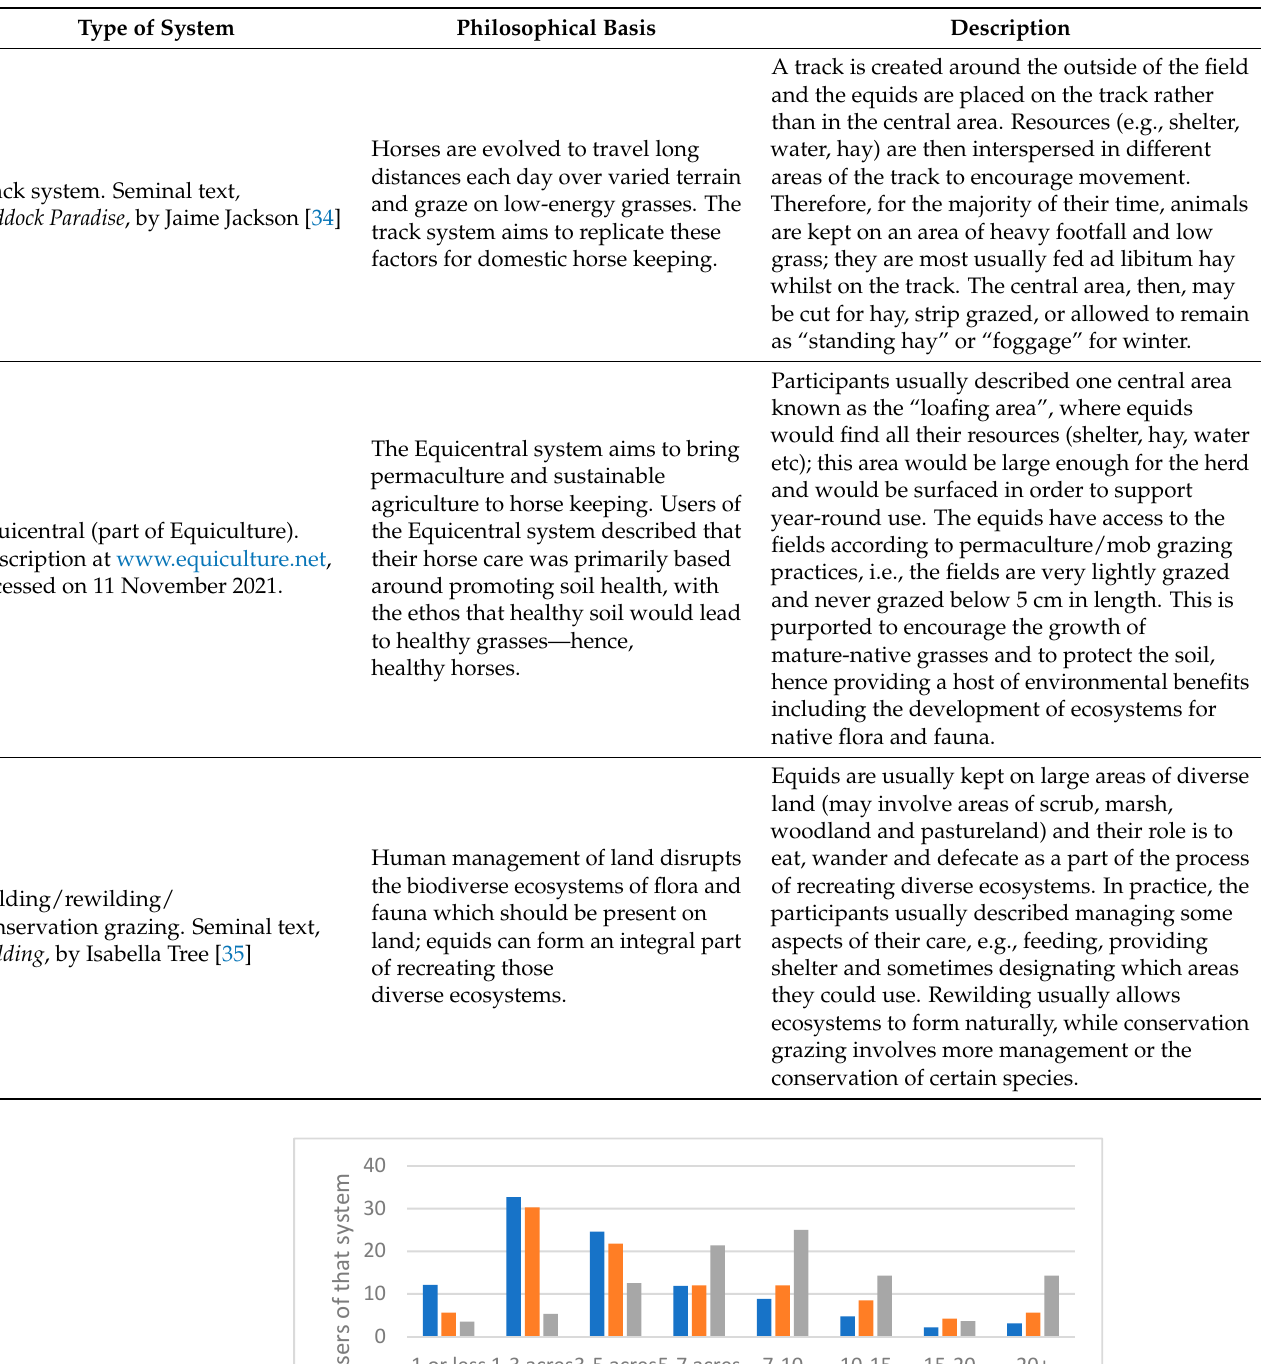
Table 2. A description of each system, showing both the philosophical basis (from the literature) and participants’ descriptions of a typical system.